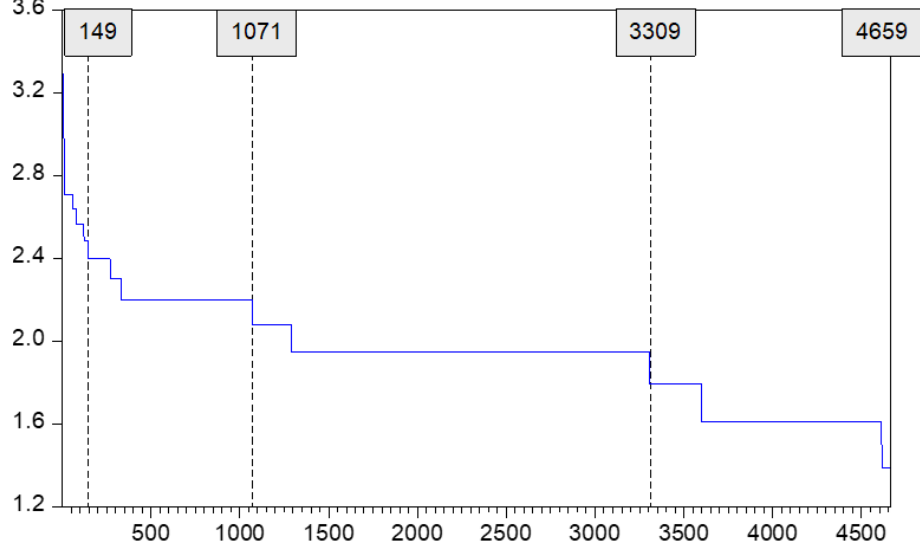
Figure 1. The breakpoints of the board